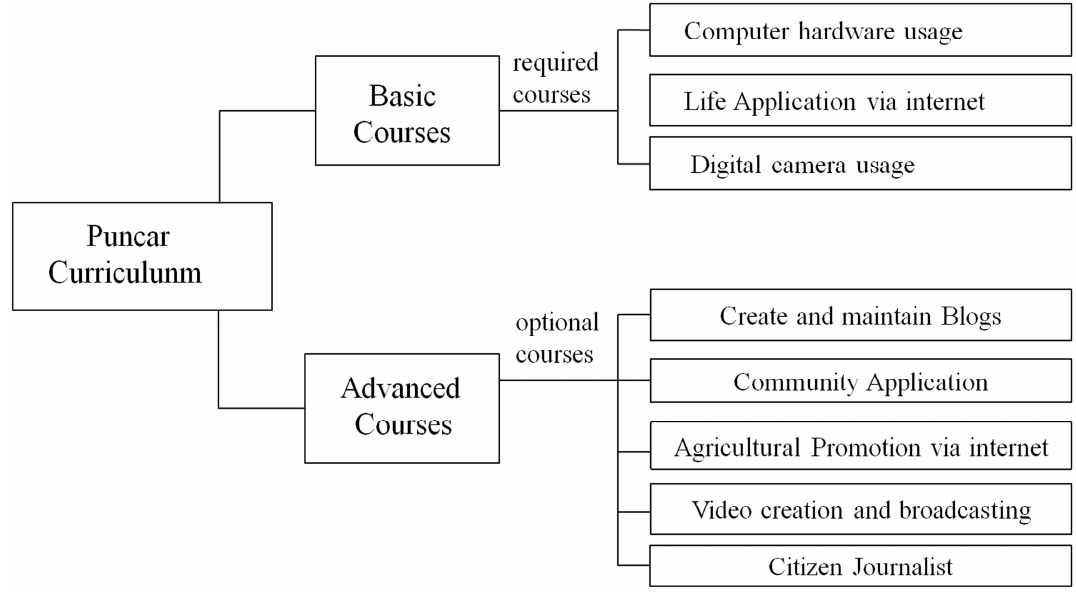
Figure 3. PunCar